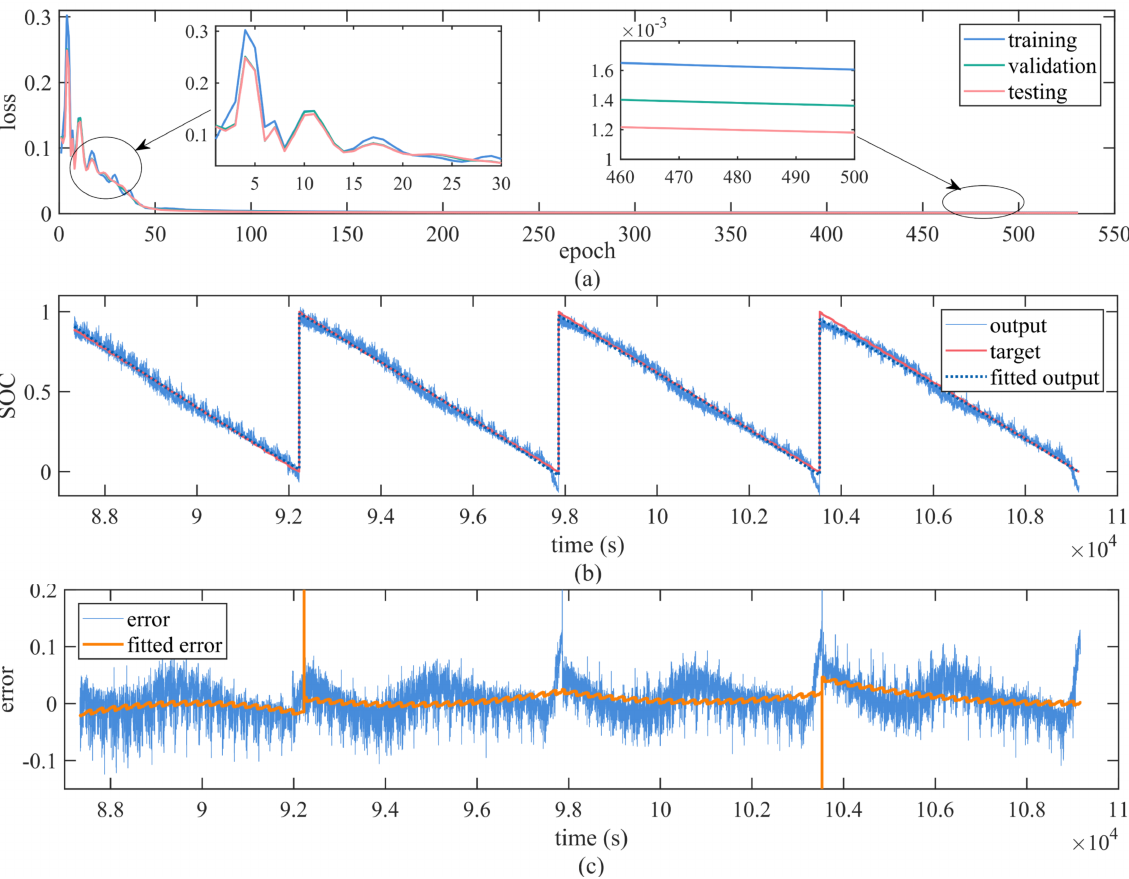
Figure 9. Training process and output performance of fPIRNN. ( a ) Training, validation, and testing loss; ( b ) output SOC with fitting; ( c ) output